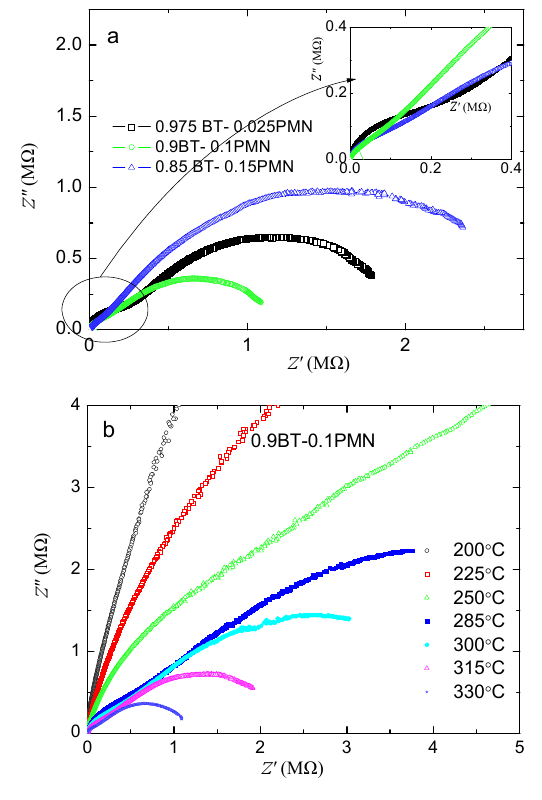
Fig. 8 Complex impedance Z  versus Z  plots: (a) at temperature 330 ℃ for selected compositions; (b) for 0.9BT–0.1PMN ceramic at different temperatures.